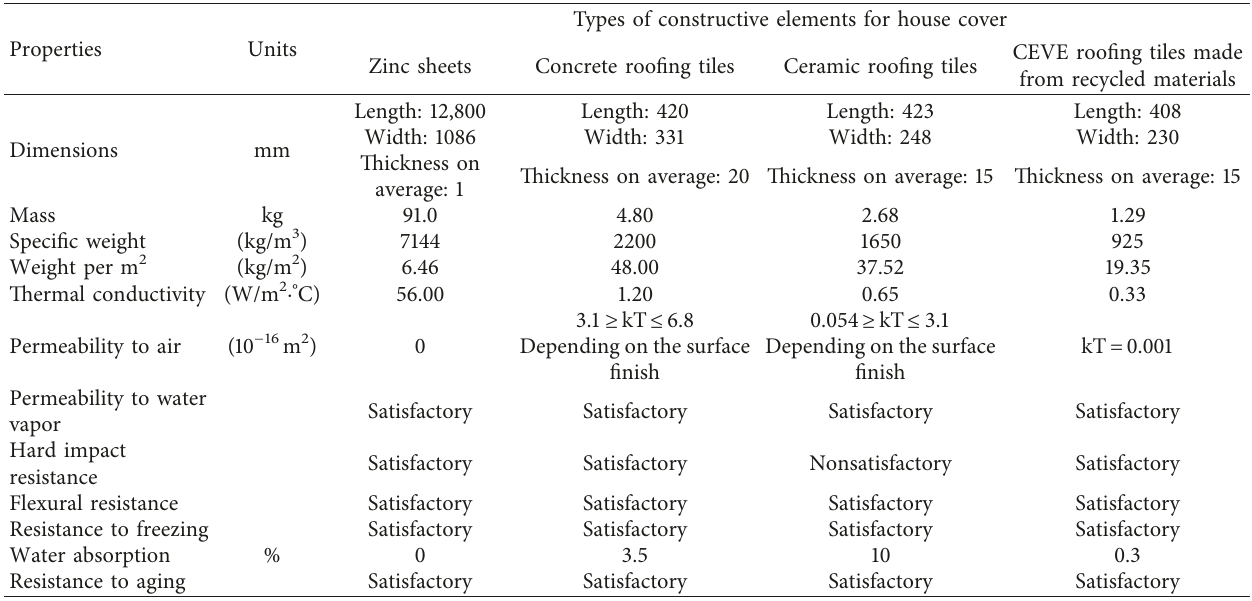
Table 2: Technical properties of constructive elements for house